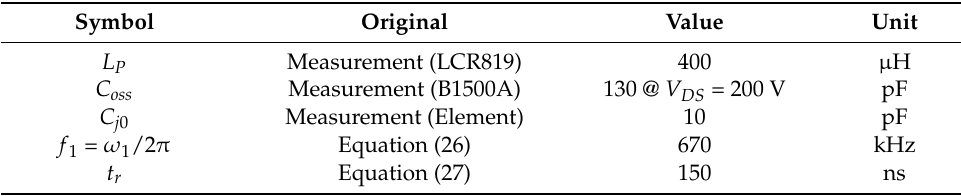
Table 3. Parameters used to estimate the rising time.